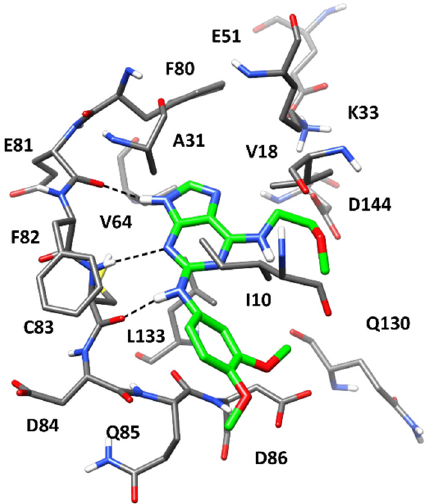
Figure 4. Minimized average structures of CPD4 (green) in complex with Cdk5. The protein residues surrounding the ligand, constituting the binding site, are shown as grey sticks, whereas hydrogen bonds are shown as black dashed